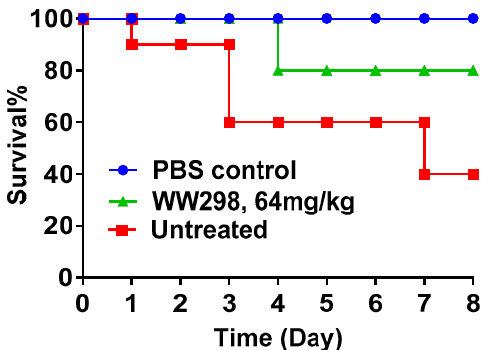
Figure 8. Protection of Galleria mellonella (wax moth) from S. aureus USA300 infection by WW298. The animals were infected 2 h prior to treatment with PBS or peptide. PBS was injected into a control set of worms to ensure peptide treatment being the only cause of worm survival upon infection.